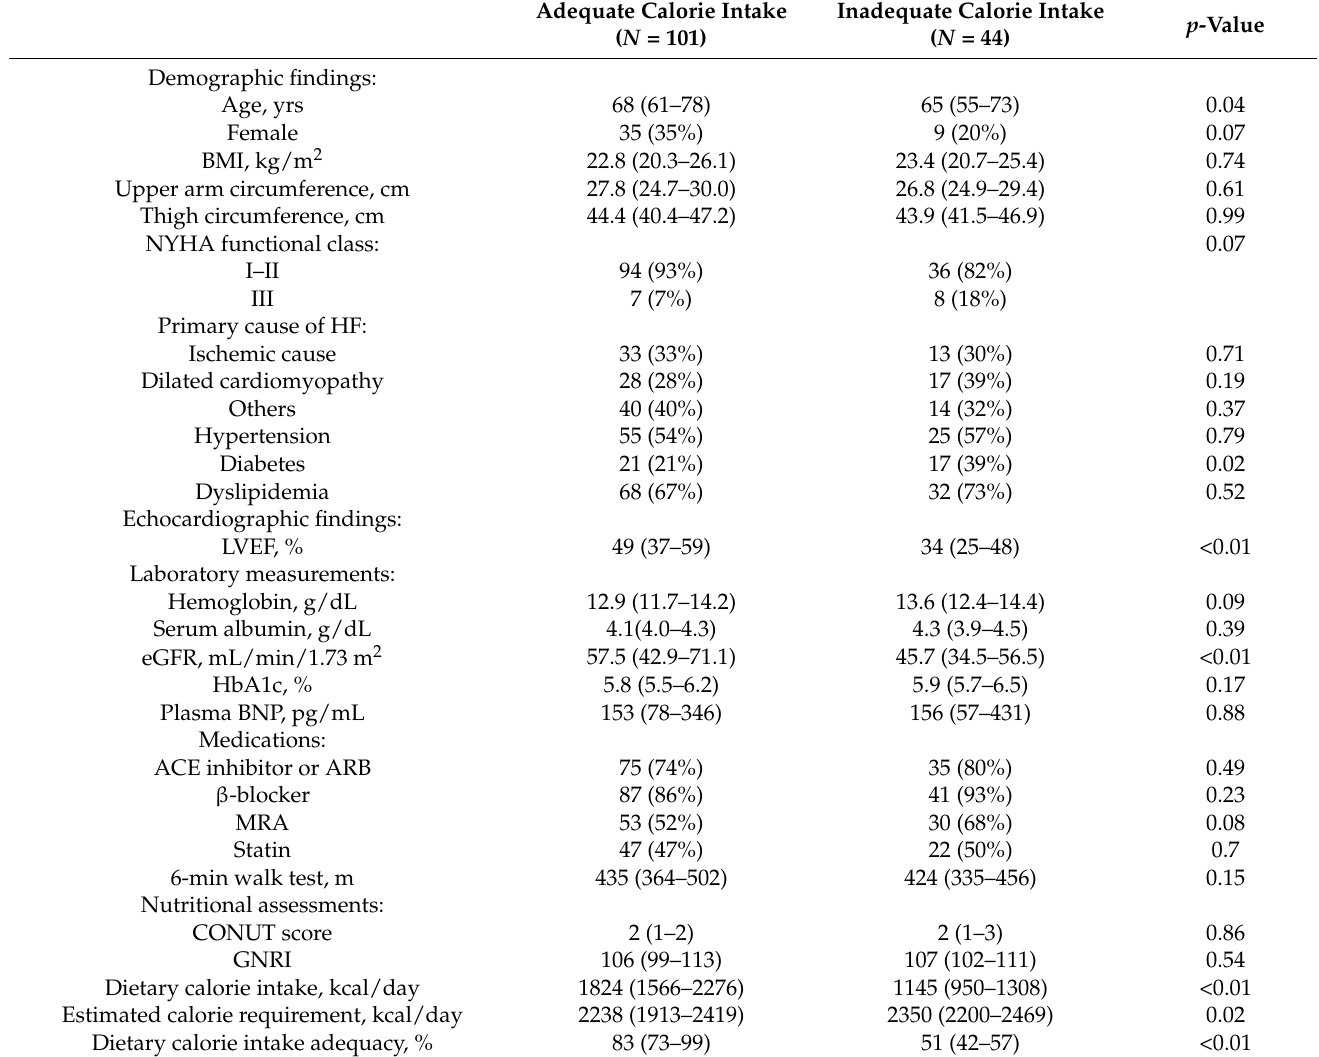
Table 2. Characteristics of chronic HF patients with adequate calorie intake and those with inadequate calorie